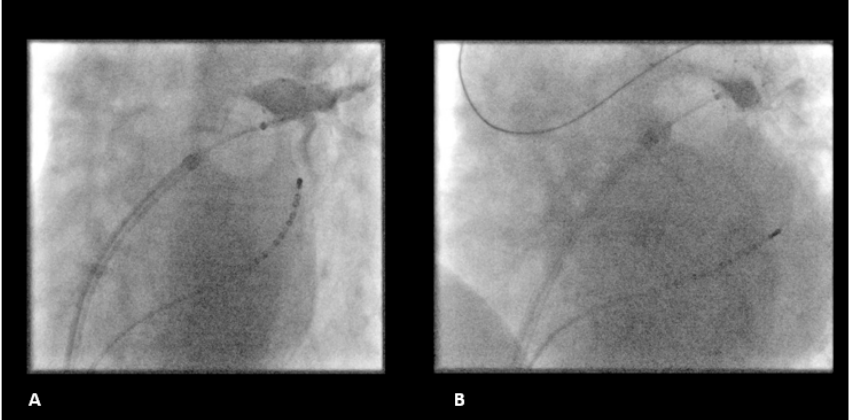
Figure 2. Fluoroscopic example of LSPV freezing. ( A ) LSPV freezing with the POLARx compared to the ( B ) AFA CBA catheter. CBA, cryoballoon ablation.